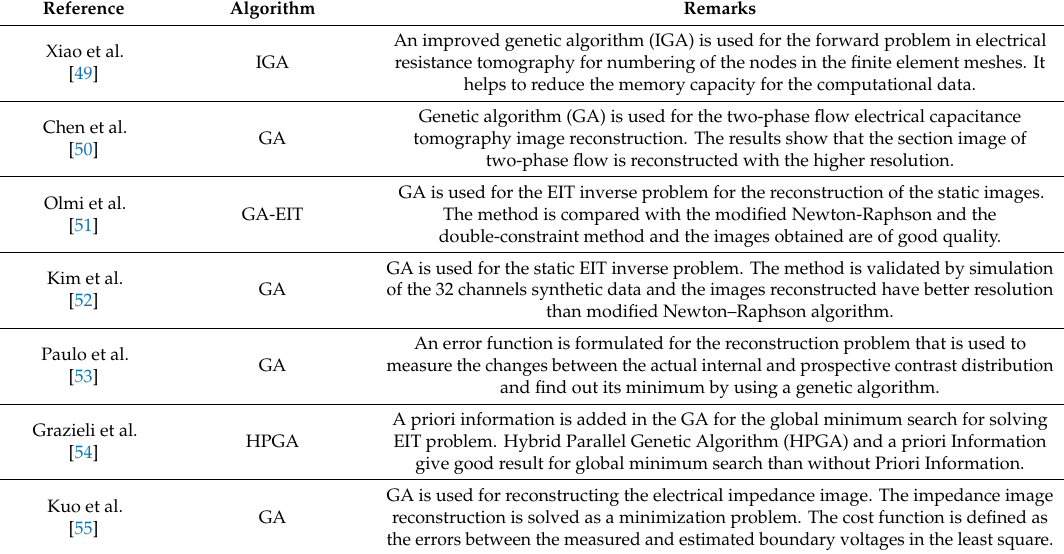
Table 3. Overview of papers using a genetic algorithm (GA) for solving the inverse